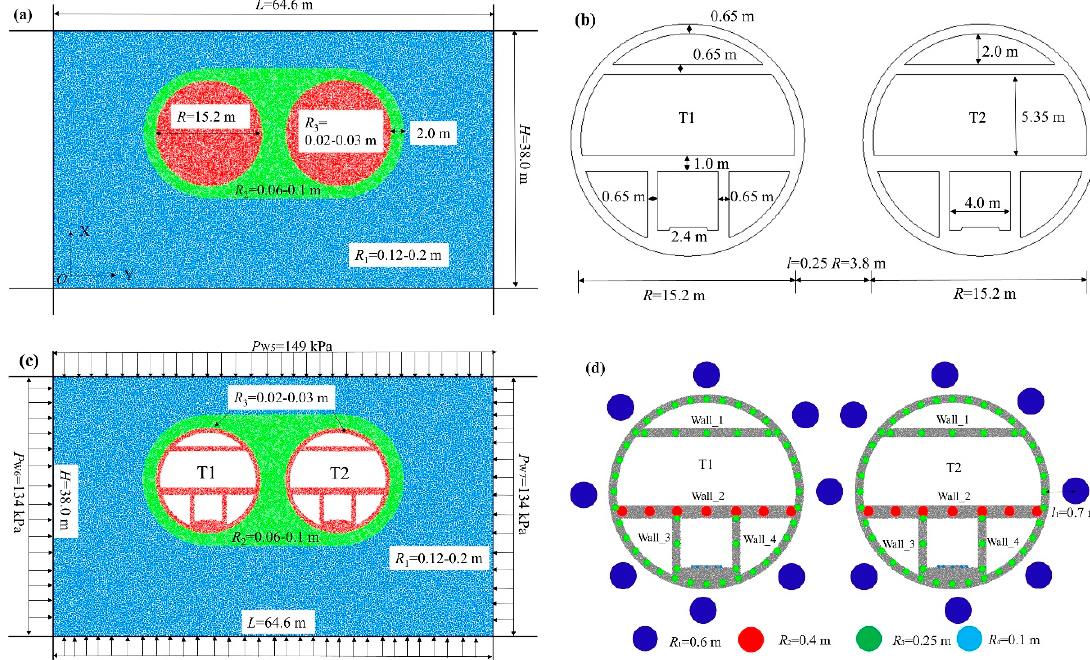
Figure 7. The process of DEM model setup of super-large diameter ( D = 15.2 m) twin tunnels: ( a ) The initial model of super-large diameter twin tunnels; ( b ) the size of the geometry of super-large diameter twin tunnels; ( c ) the cross-section of super-large diameter twin tunnels; ( d ) detailed layout of monitoring points of the super-large diameter twin tunnels. Table 4. Parameters of small ( d ) and super-large ( D ) twin tunnels in the DEM model.